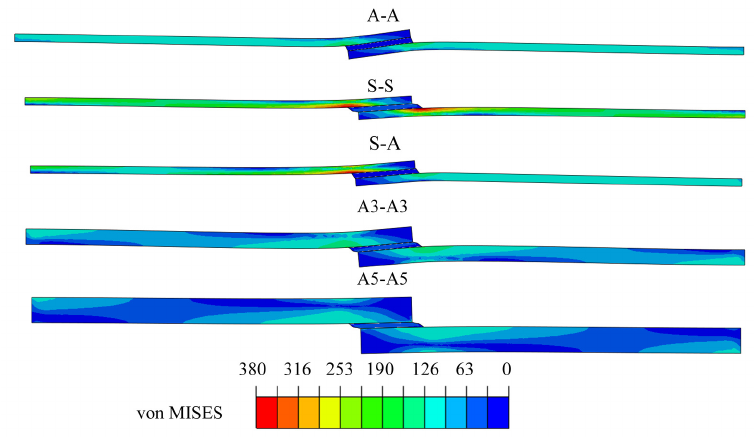
Figure 20. The form of strain of single-lap joints under the impact of loading force determined by the numerical method.